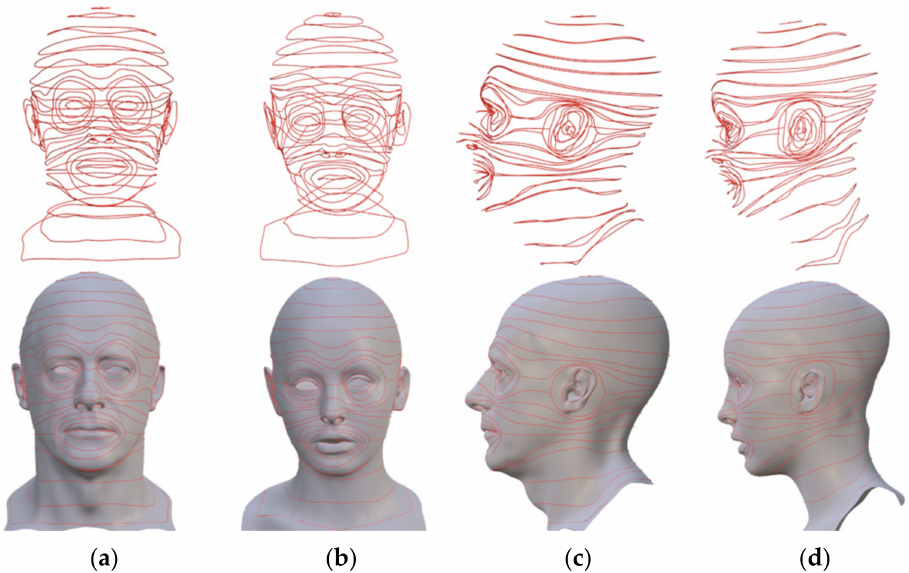
Figure 4. Front and side view of the design of the curves dividing a canonical 3D face model into patches, ( a , c ) are a source male face model, ( b , d ) are a target female face model. Next, the extracted curves from a source model w 0 ( u , v ) and a target model w 1 ( u , v ) are represented with time-independent Fourier series expressions. After that, each of the time-independent Fourier series expressions is introduced into the solution to a selected vector-valued second-order partial differential equation to create curves-defined PDE sur- faces, which are used to rebuild the 3D models. By doing so, we convert the correspondence between vertices of polygon models into the correspondence between the extracted curves. The extracted curves are represented with Fourier series in the form of Equation (13) to benefit the following interpolation and blending